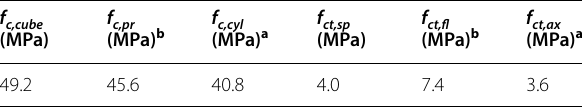
Table 1 Specimens H50-f1 and H50-f2 under flexure: experimental values of concrete mechanical properties.